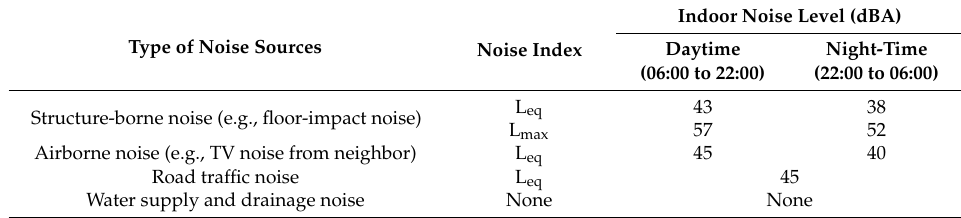
Table 1. Korean regulation on acceptable indoor noise level for different noise